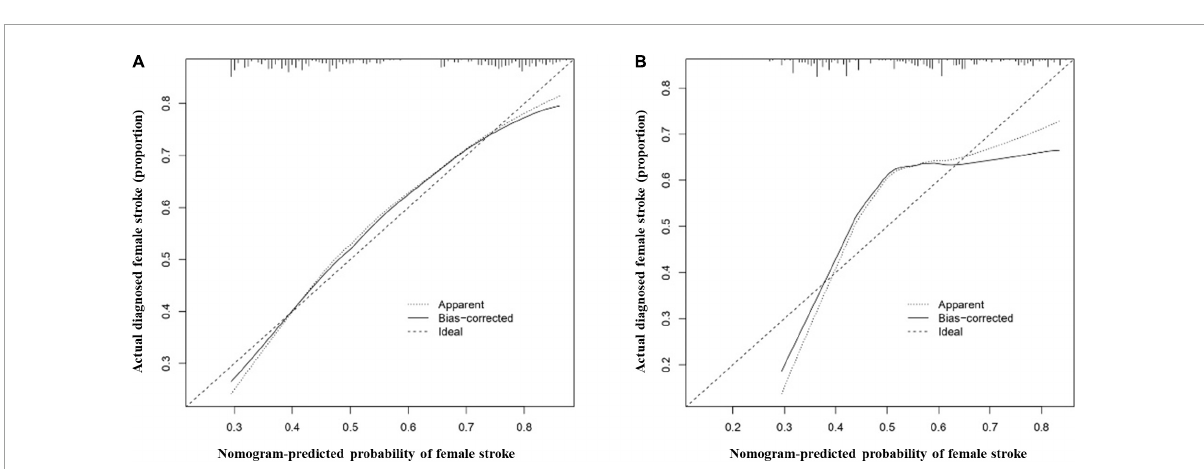
FIGURE7 Calibration curves for the female nomogram prediction models. (A) illustrates the nomogram for the training cohort ( n = 1051) with a mean absolute error of 0.017 and (B) illustrates the nomogram for the validation cohort ( n = 350) with a mean absolute error of 0.062. The x -axis indicates the predicted IS incidence and the y -axis indicates the actual incidence of IS. The dotted diagonal line shows the model for perfect prediction, while the solid line illustrates the performance of the nomogram. The shorter the distance between the dashed line and the diagonal line, the higher the prediction accuracy of the